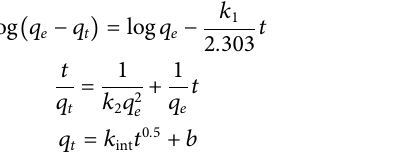
Frontiers in Environmental Science |